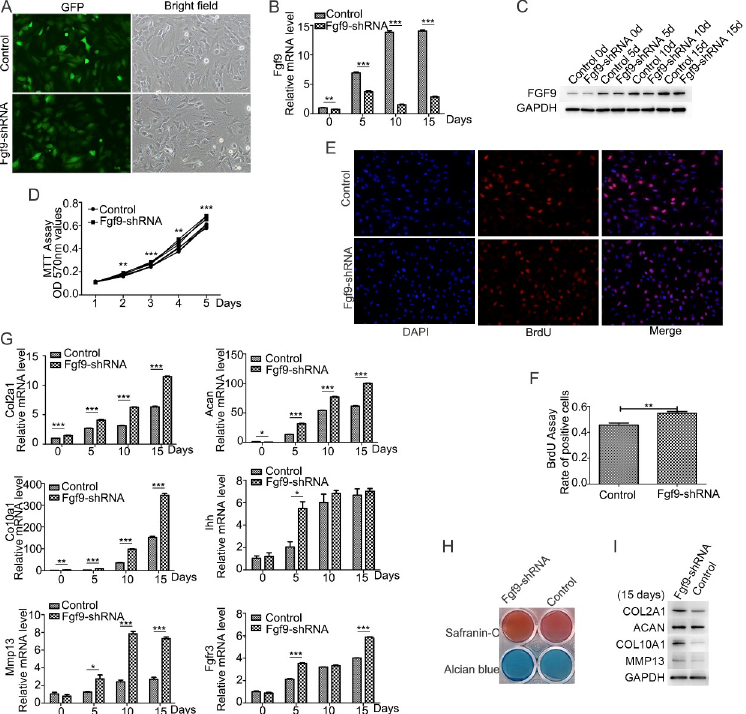
Fig 3. FGF9 silencing promoted the ITS-induced chondrogenic differentiation of ATDC5 cells. The efficiency of lentivirus-infected cells was observed by the same field fluorescence and bright light cell density under the control microscope (A). FGF9 silencing in the ATDC5-FGF9-shRNA cells was detected by quantitative real-time PCR (B) and Western blotting (C). MTT assay showed that FGF9 silencing promoted the proliferation of undifferentiated ATDC5 cells (D). Immunofluorescence staining was used to detect Brdu incorporation within 2 hours, Brdu positive cells were marked in red, and nuclear markers were blue (E), and the ratio of positive cells to total cells was calculated (F). Quantitative real-time PCR (G) and Western blotting (I) showed the increased expression of chondrogenic markers Col2a1, Acan, Col10a1, and Mmp13, when FGF9 was silenced. FGF9 silencing promoted Safranin-O staining and Alcian blue staining (E) on the 15th day of induction. ( � P < 0.05; �� P < 0.01; ��� P <